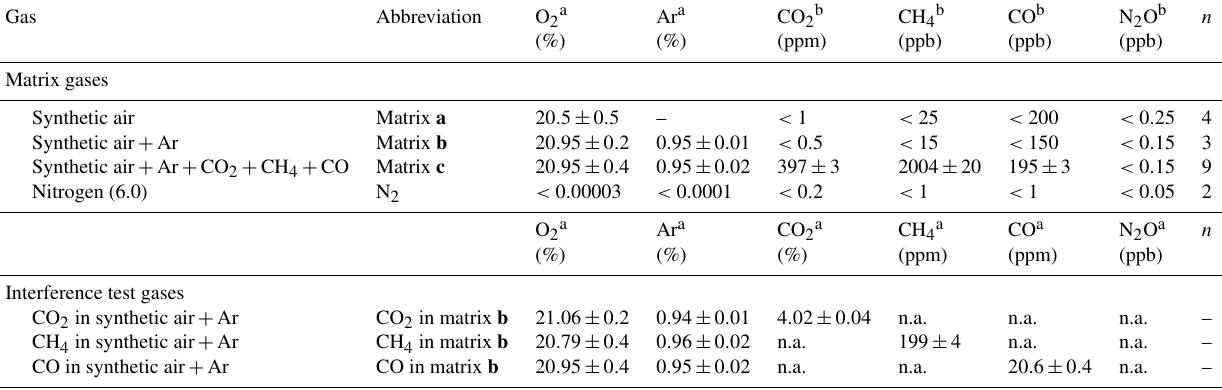
Table 2. O 2 , Ar content and trace gas concentrations for matrix and interference test gases. Trace gas concentrations of matrix gases were analyzed by WMO GAW WCC Empa against standards of the NOAA/ESRL/GMD. For trace gas concentrations of interference test gases, manufacturer specifications are given. Reported O 2 and Ar content is according to manufacturer specifications. The given uncertainty is the uncertainty stated by the manufacturer or the standard deviation for analysis of n cylinders of the same